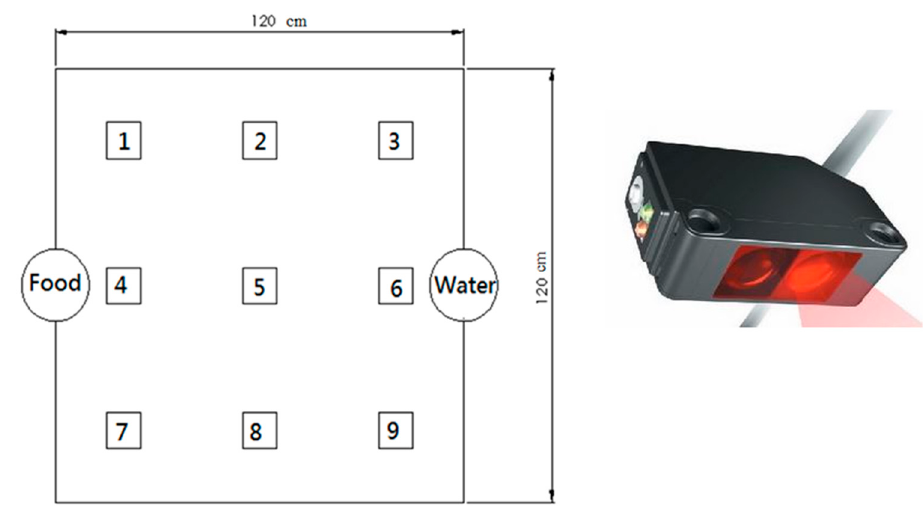
Figure 12. The basic distribution of switch sensors in the ABC. Each number in the cage represented the sensor number.